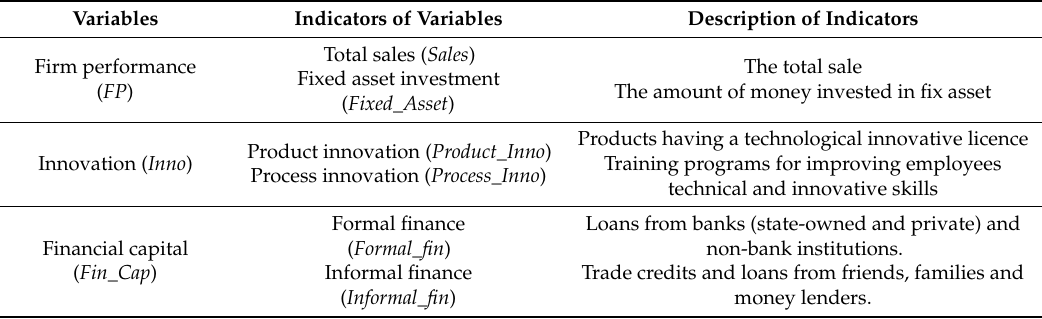
Table 4. Measurement of